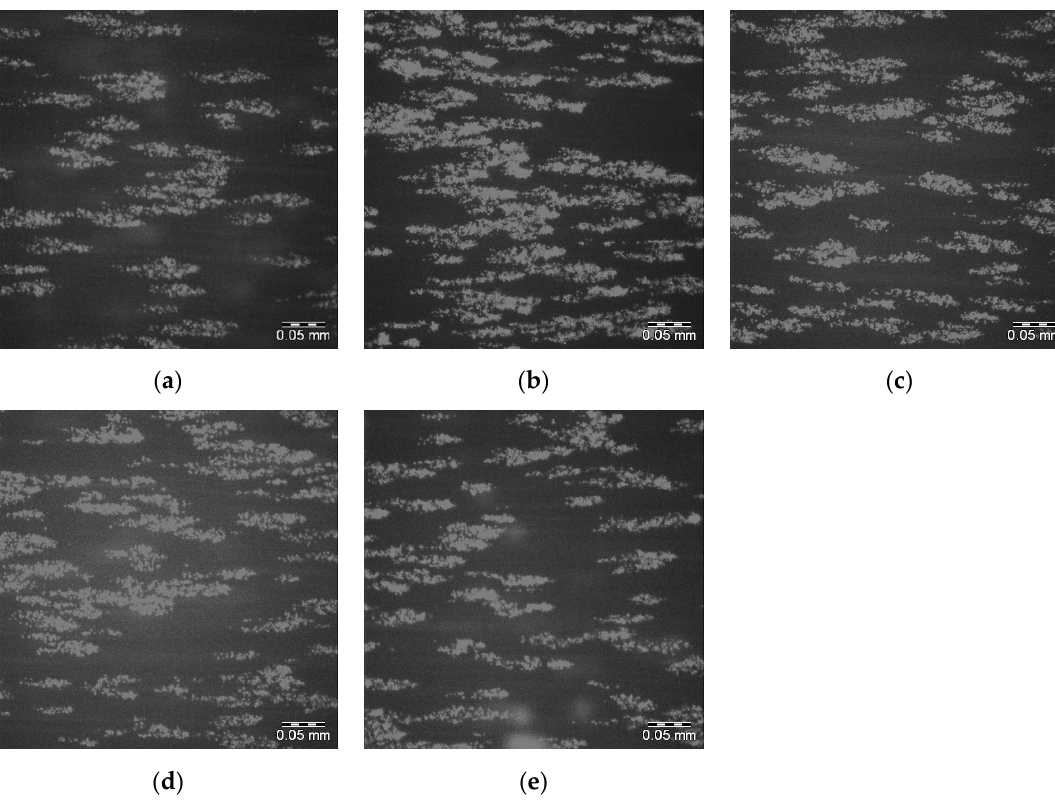
Figure 5. Fluoresence micrographs of whole blood DIOC 6 labelled platelets adhered to the surface of each of 5 replicates ( a – e ) of the 25PS/75PMMA demixed spin coated surface. Scale bar 0.05 mm.